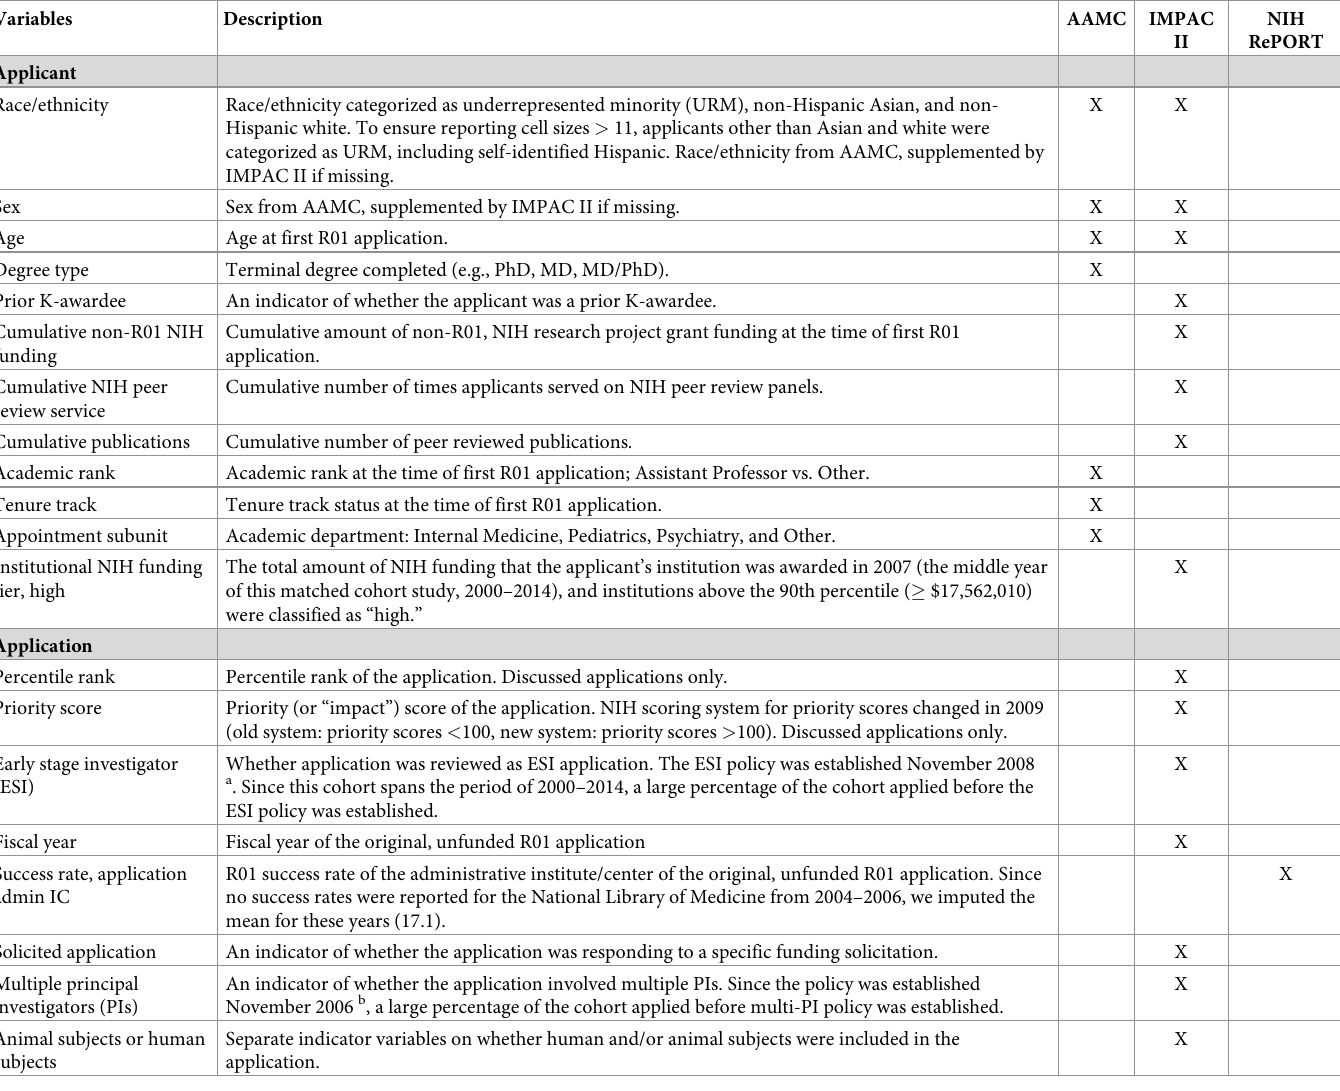
Table 1. Descriptions of variables used for the study, Association of American Medical Colleges Faculty Roster File (AAMC), National Institutes of Health adminis- trative data (IMPAC II), and NIH